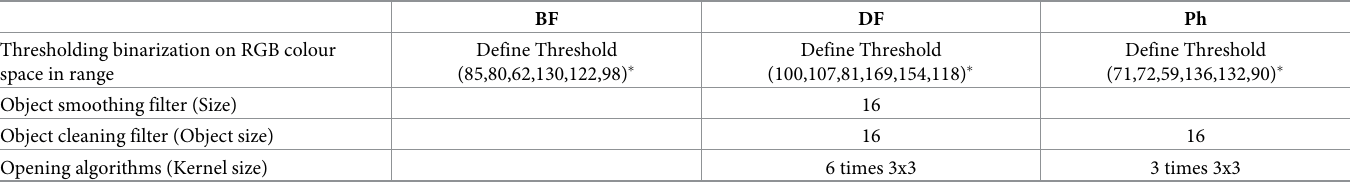
Table 1. Processing setting of objects analysis for microscopic techniques